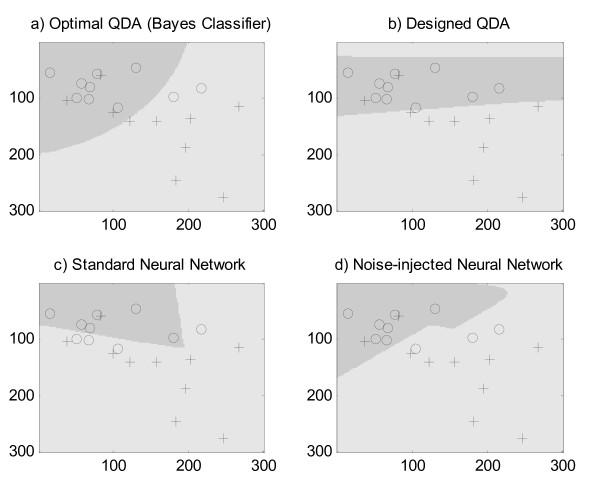
A visual comparison of different classifiers. The data model is a two-dimension nonlinear model. Sample size is 20, with 10 points from each class. The samples from class 0 and class 1 are denoted with round and cross markers, respectively. The shading denotes the decision region determined by the corresponding classifier, with darker shade for class 0 and lighter shade for class 1. The structure of the neural network is 2-4-2.